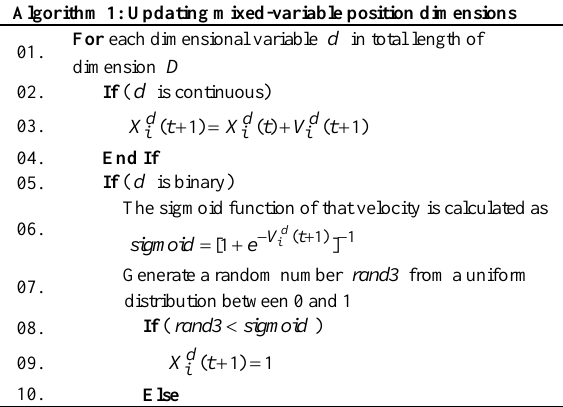
Table 1. Pseudo-code for updating mixed-variable position dimensions in the proposed algorithm. Algorithm 1: Updating mixed-variable position